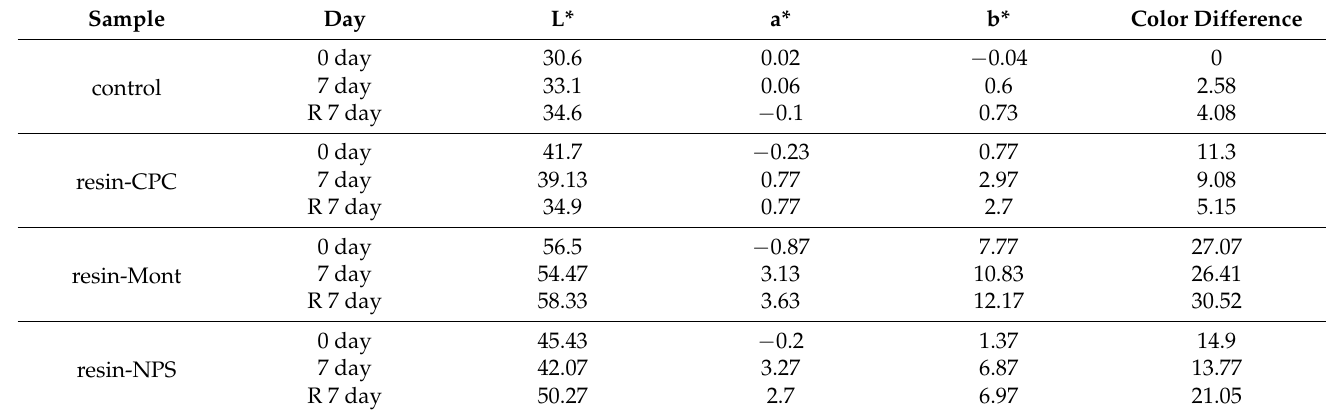
Table 2. Change in color tone test results (“after reuptake” is denoted by